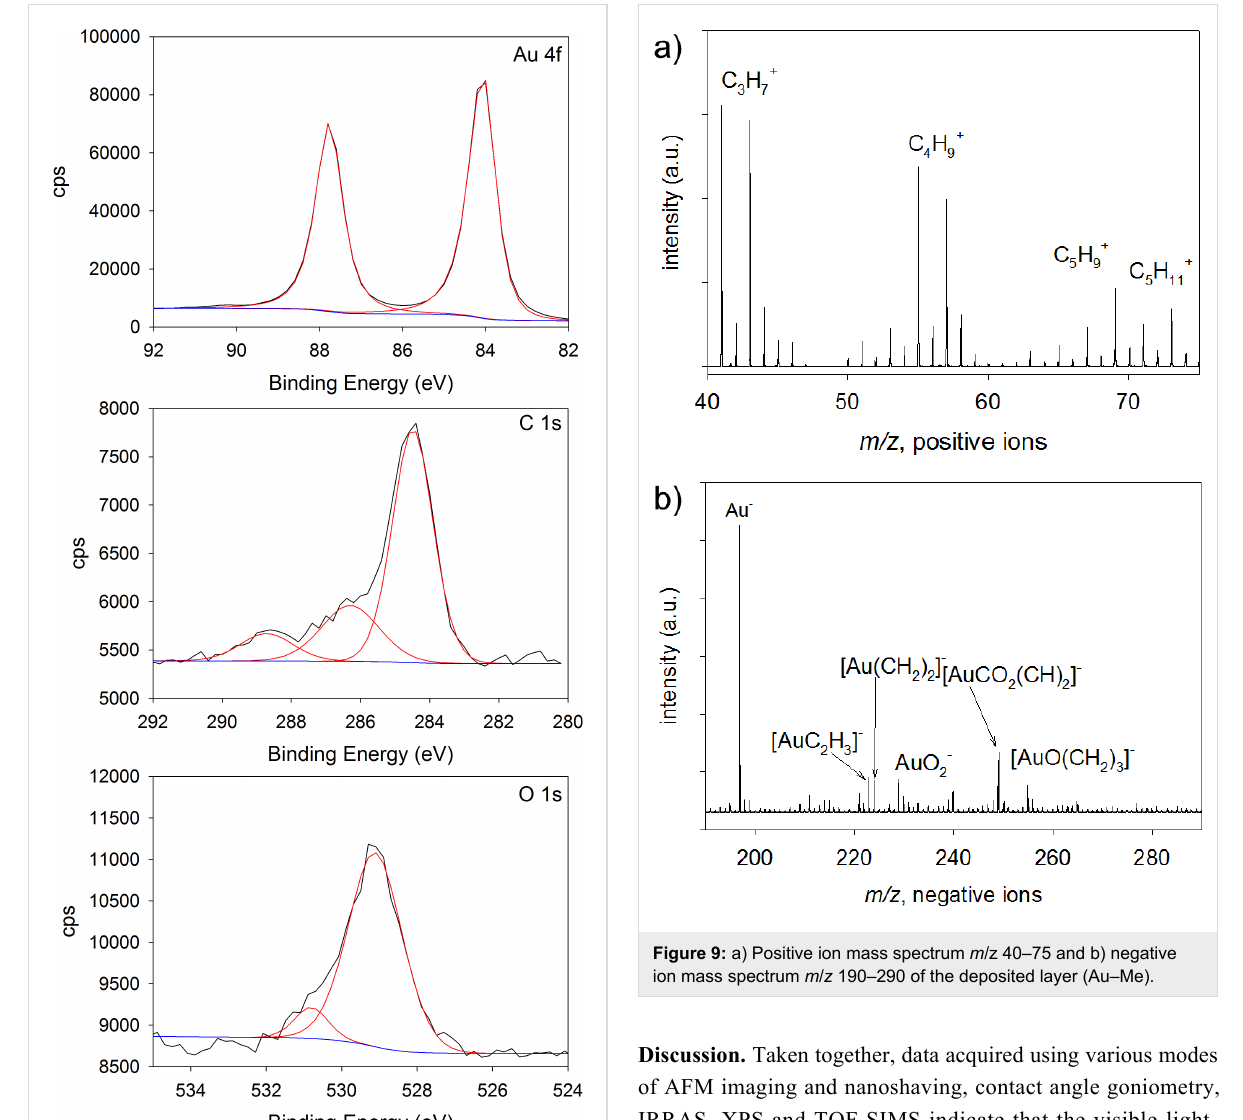
(Figure 9b). The data indicate that some of the layer may be bound to the Au substrate via Au–C bonds ([Au(CH x ) y ] − ). In light of the XPS data in which metal–carbon bonds were not ob- served, the number of Au–C bonds would have to be small rela- tive to the number of decyl radicals or decane molecules deposited in the film. The presence of the oxygen-containing ions also indicates that some of the deposited layer may be bound to the substrate via Au–carboxylate (CO 2 –Au) bonds [67,68] which have also been observed in the formation of alkyne monolayers on gold [69]. As before, the lack of Au oxi- dation observed with XPS indicates that CO 2 –Au bonding at the surface is not likely to be